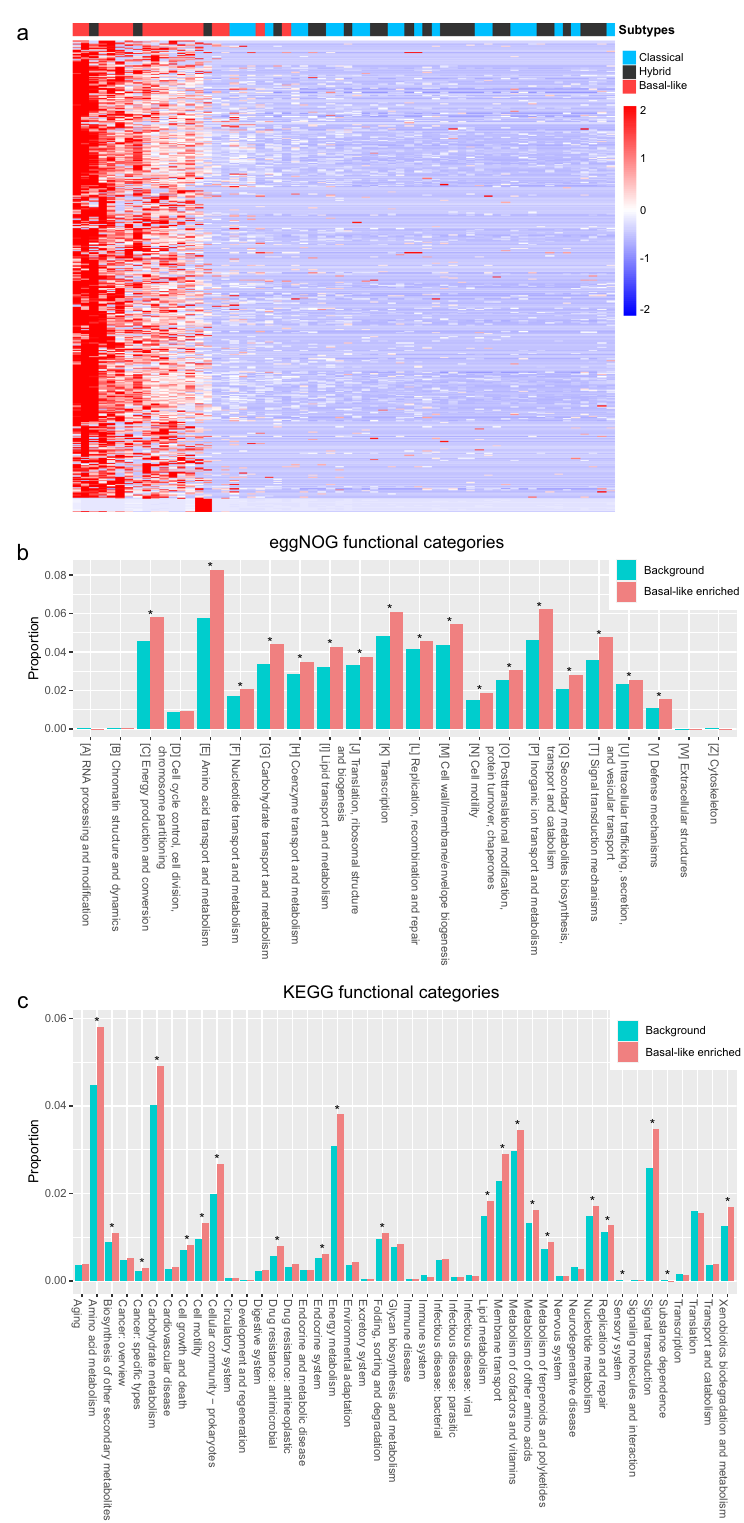
Fig. 4 Microbial genes enriched in basal-like tumors display higher pathogenicity. a Heatmap of microbial genes with differential abundance across all PDAC samples. The heatmap contains 8960 genes (rows) and 62 samples (columns). b Comparison between the Basal-like enriched and background genes on OG functional categories. c Comparison between the Basal-like enriched and background genes on level 2 of KEGG functional categories. Signi fi cance was determined by Fisher ’ s exact